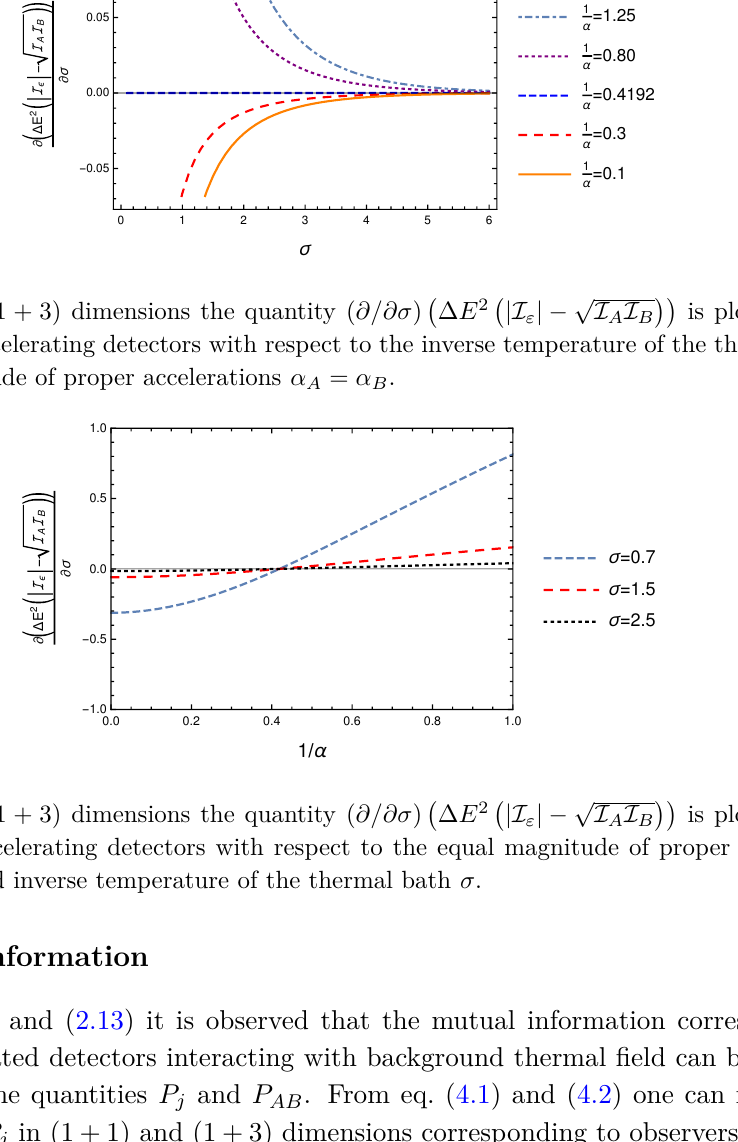
√ (cid:0) ∆ (cid:0) (cid:1)(cid:1) is plotted for two E 2 |I ε | − I A I B